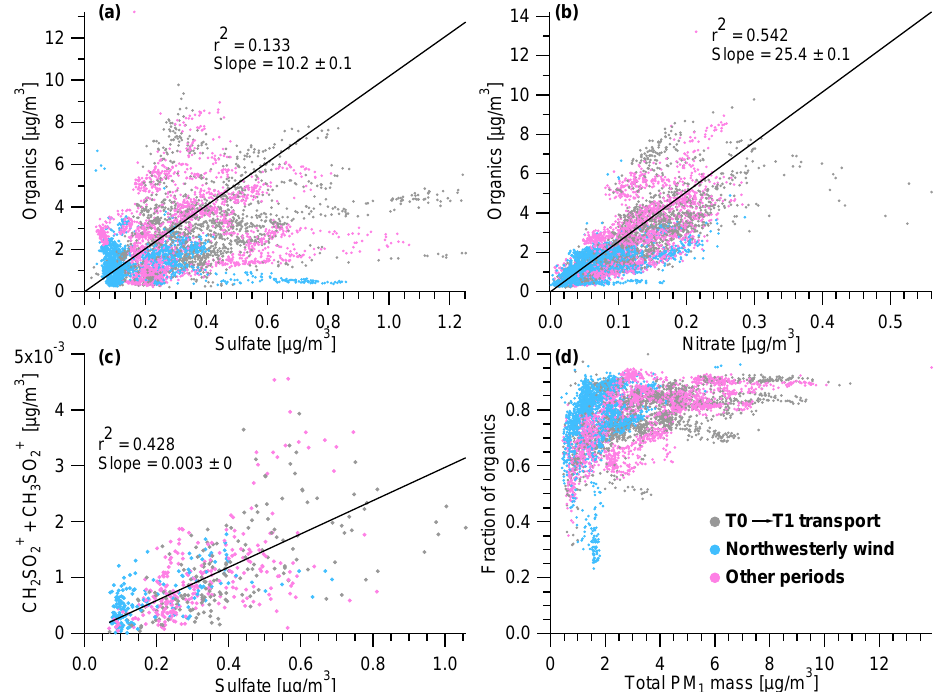
Fig. 5. Scatterplots of (a) organics vs. sulfate, (b) organics vs. nitrate, (c) sum of the main MSA ions vs. sulfate (1-h averaged data), and (d) fraction of organics vs. PM 1 mass. All the scatterplots are colored by air mass types. The data fitting was performed using the orthogonal distance regression